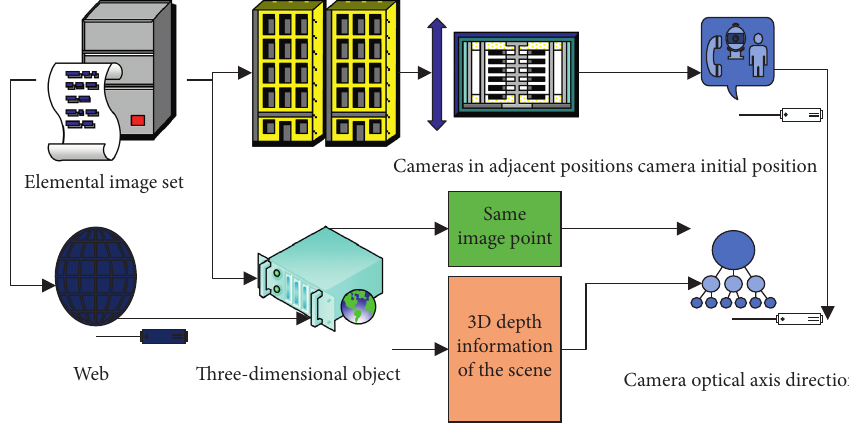
Figure 2: Axial distribution perception